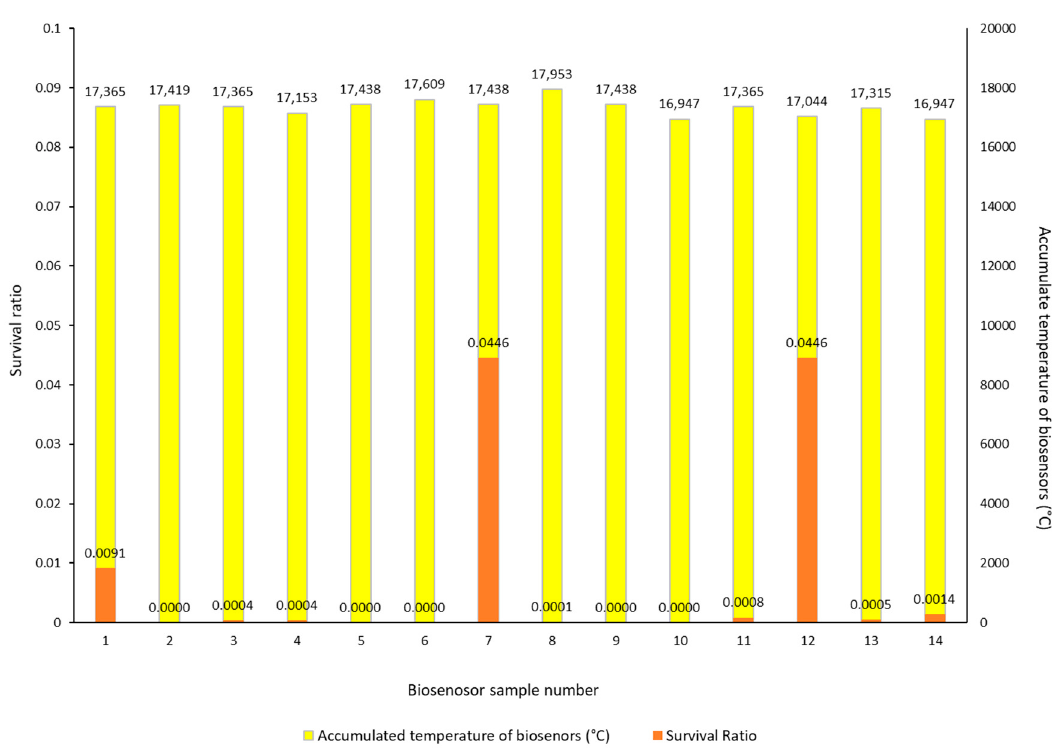
Figure 6. Accumulated temperature and survival ratio of biosensors during the entire treatment process (400 s).